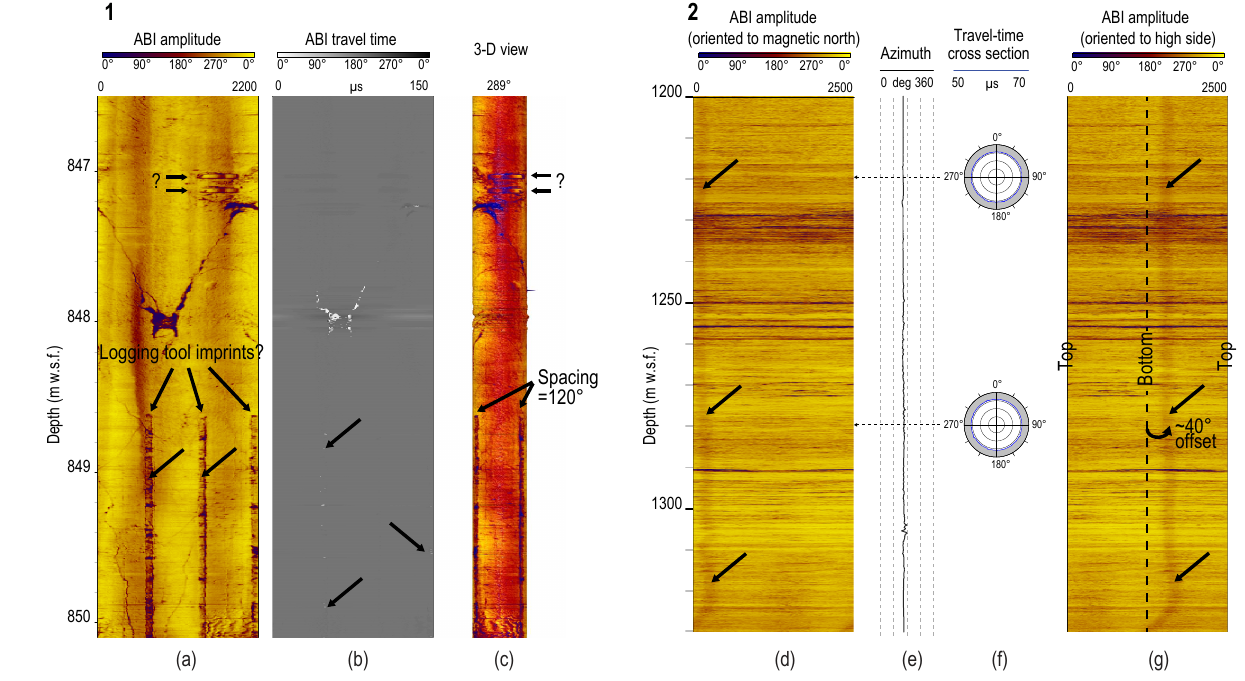
Figure 8. Marks on the borehole wall. (1) possible tool imprint oriented to 120 ◦ , and residue possibly left in mud residue by arms of the mechanical caliper. (2) ABI image oriented with respect to the magnetic north (d) and to the high side, (g) illustrating that the continuous regular narrow dark stripe (black arrows) is closely related to borehole inclination and may be the result of the drill pipe rubbing on the borehole wall. (f) travel-time cross section (magnetic north orientation) illustrates a regular borehole shape with no evidence for groove cut to be associated with the narrow dark stripe. Note that the travel-time cross sections’ lower limit has been set to